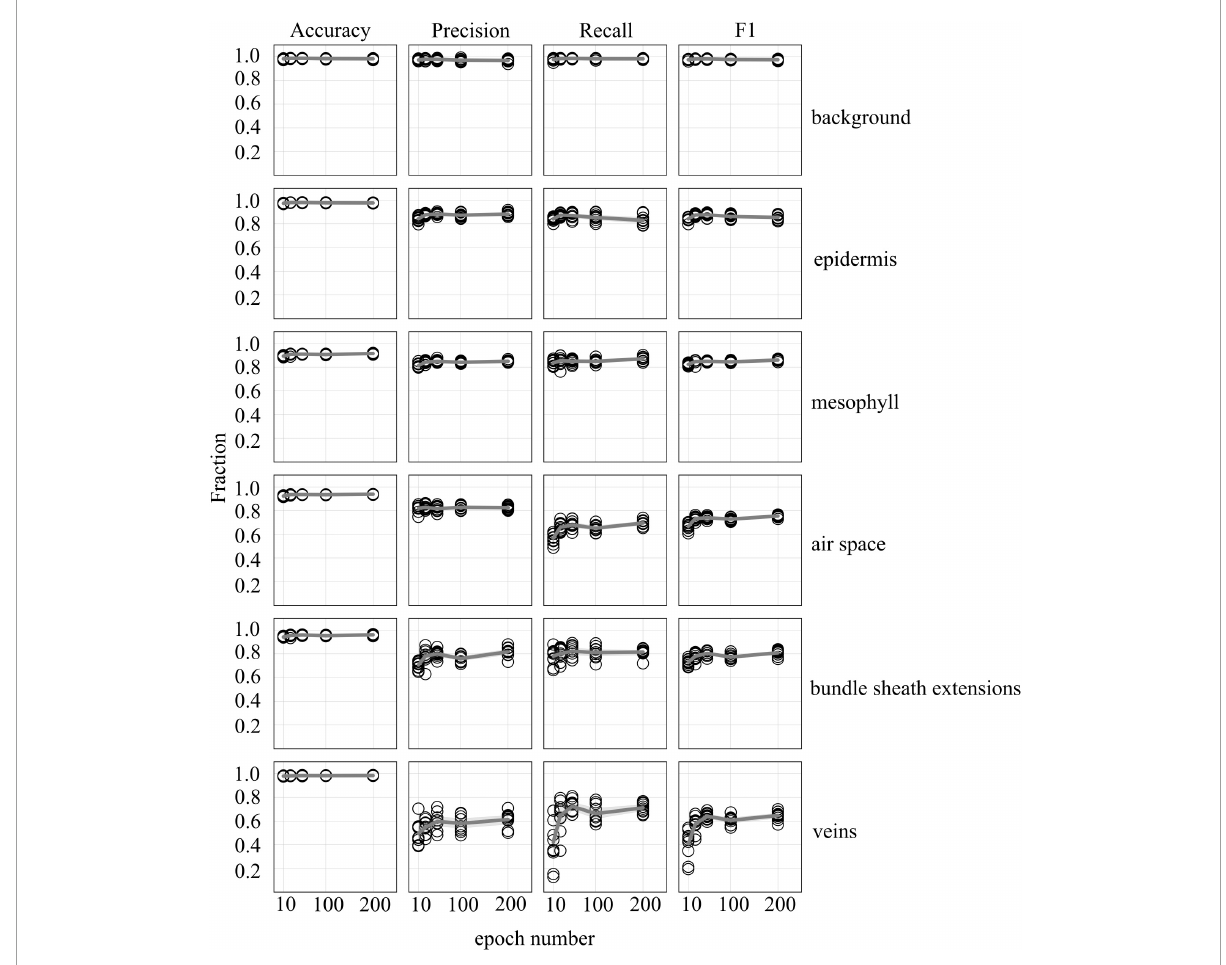
FIGURE4 Accuracy, precision, recall, and F1 scores as a function increasing epoch number for models trained on annotated images from 5 leaves (5 annotated images per leaf) used to predict tissue classes from X-ray µ CT images from an independent leaf on which the models were not trained or validated. Circles represent unique predictions from 10 uniquely generated models per epoch number; dark gray lines represent the mean value of the 10 models for each tissue type while thick light gray lines represent the 95% confidence interval of the